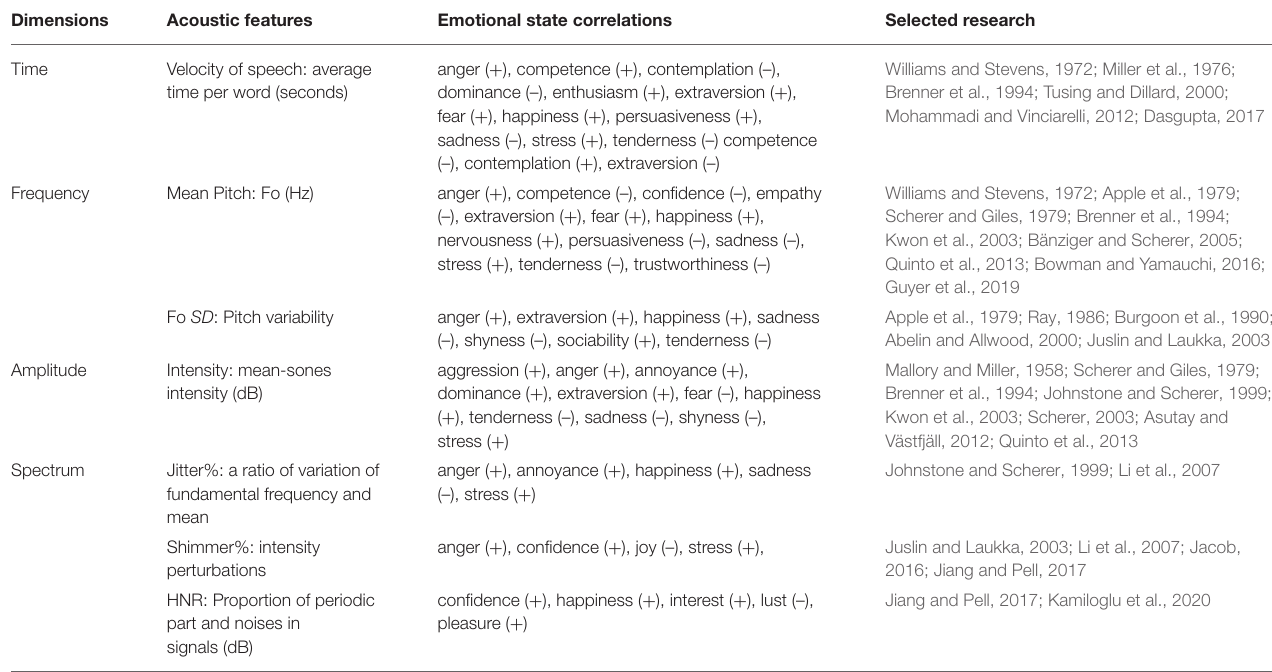
TABLE 2 | Connections between the four dimensions of acoustic features and emotions.